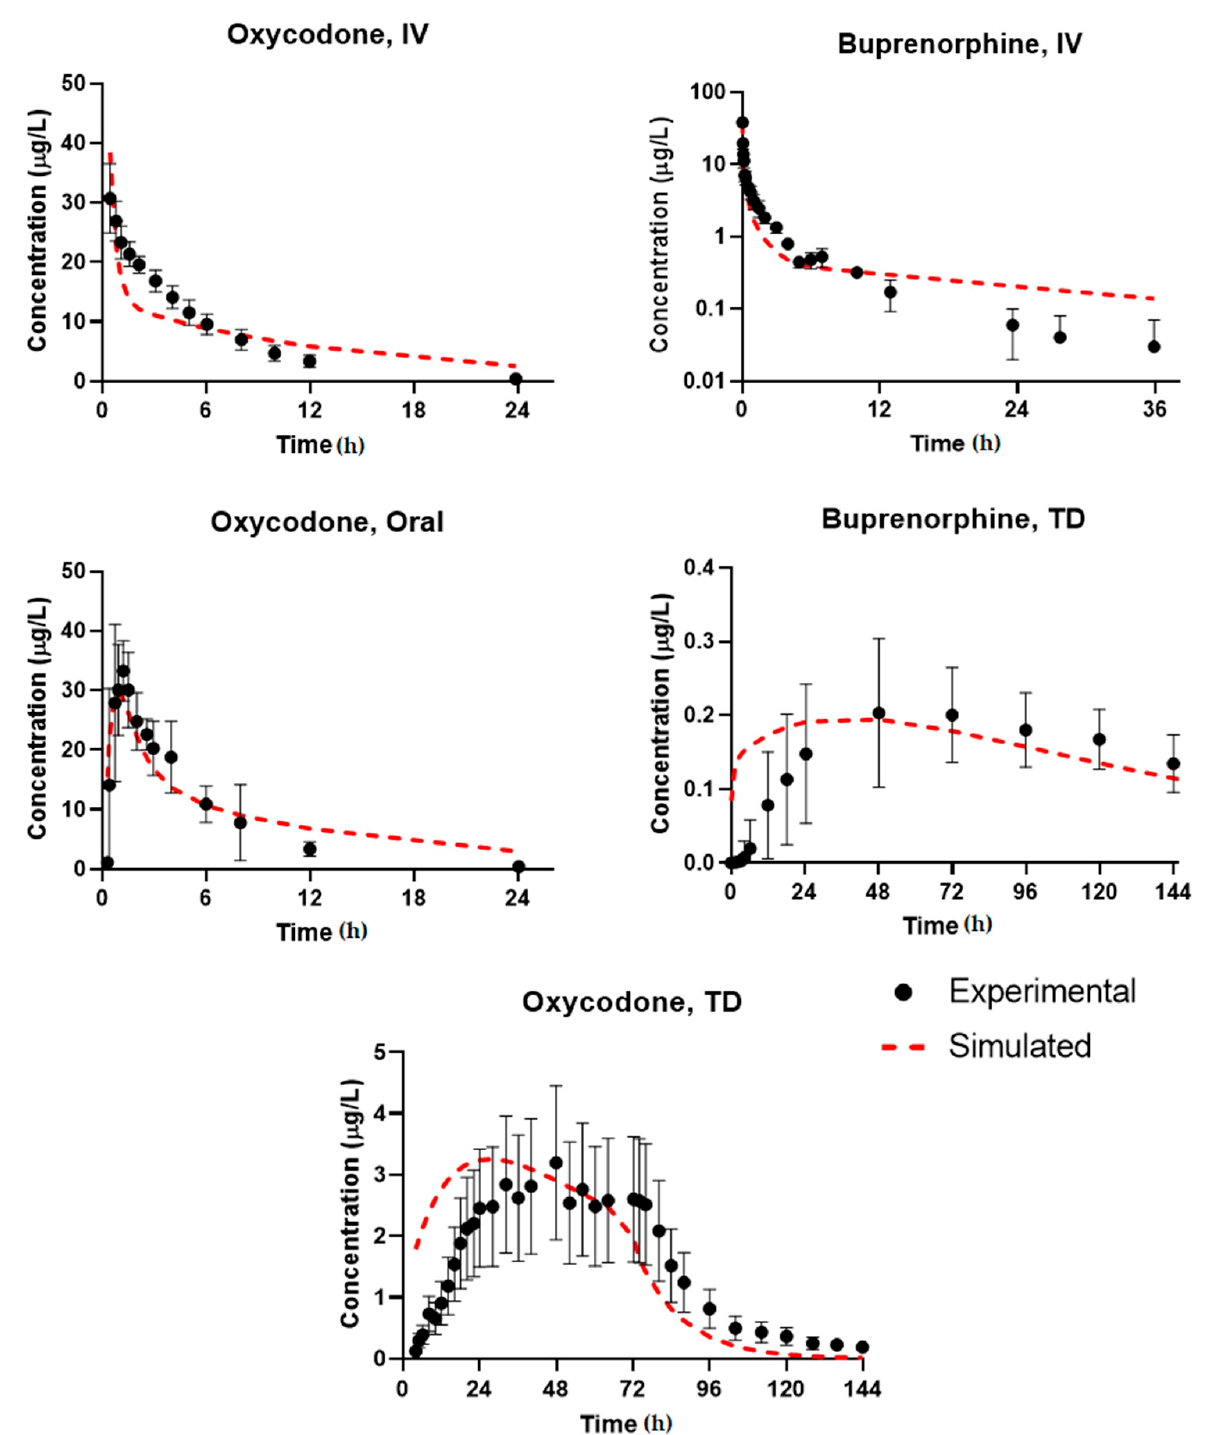
Figure 3. Dose and route-of-administration dependent prediction of compound plasma concentration for Oxycodone and Buprenorphine. Dashed lines correspond to BIOiSIM simulation outputs. Error bars and individual data points were digitized from the original publications, where available, and correspond to standard error/standard deviation, as presented in the original